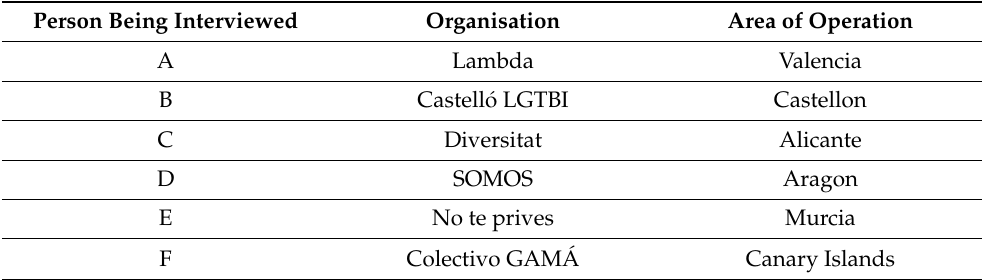
Table 2. List of people